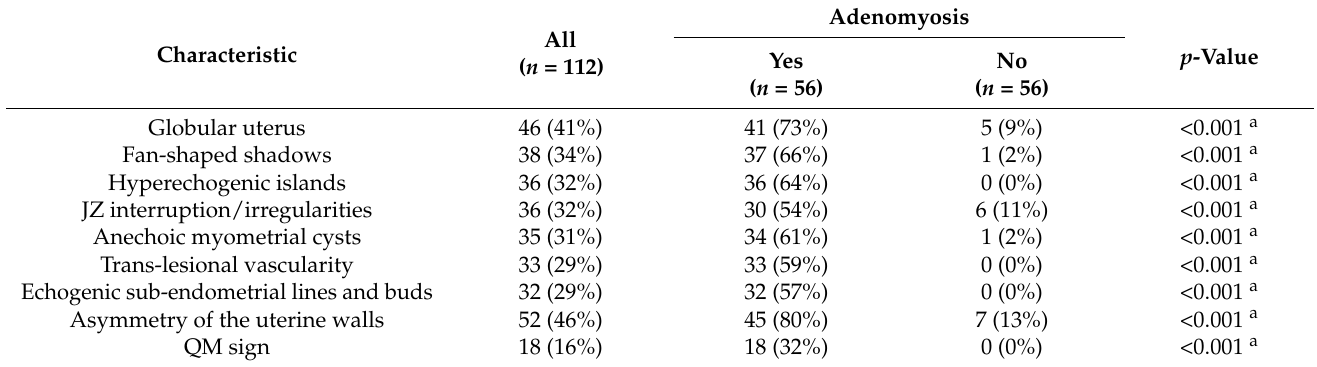
Table 2. Ultrasonographic characteristics of the entire study population and of the two study groups.